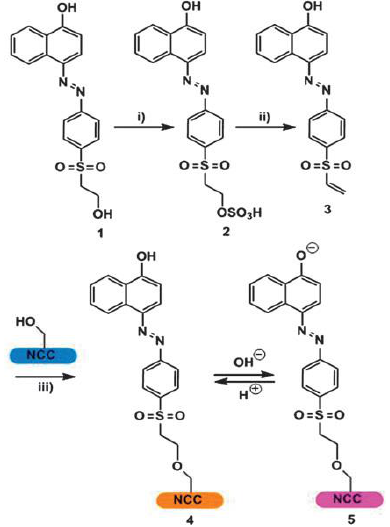
Figure 6. Synthesis of the nanocellulose dye film: (i) 96% H 2 SO 4 , 45 min, 45 °C, yield: 7.4%; (ii) NaOH 1 M until pH = 10; (iii) nanocellulose suspension in water, yield: 37%